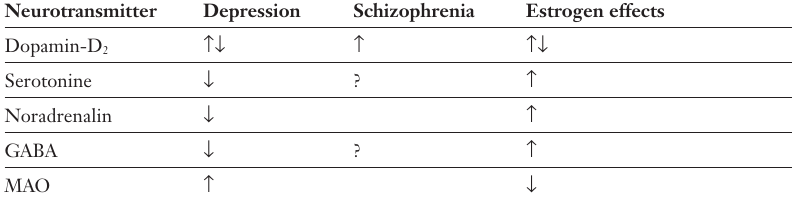
Neurotransmitter function in depres- sion and schizophre- nia – and oestrogen effects.